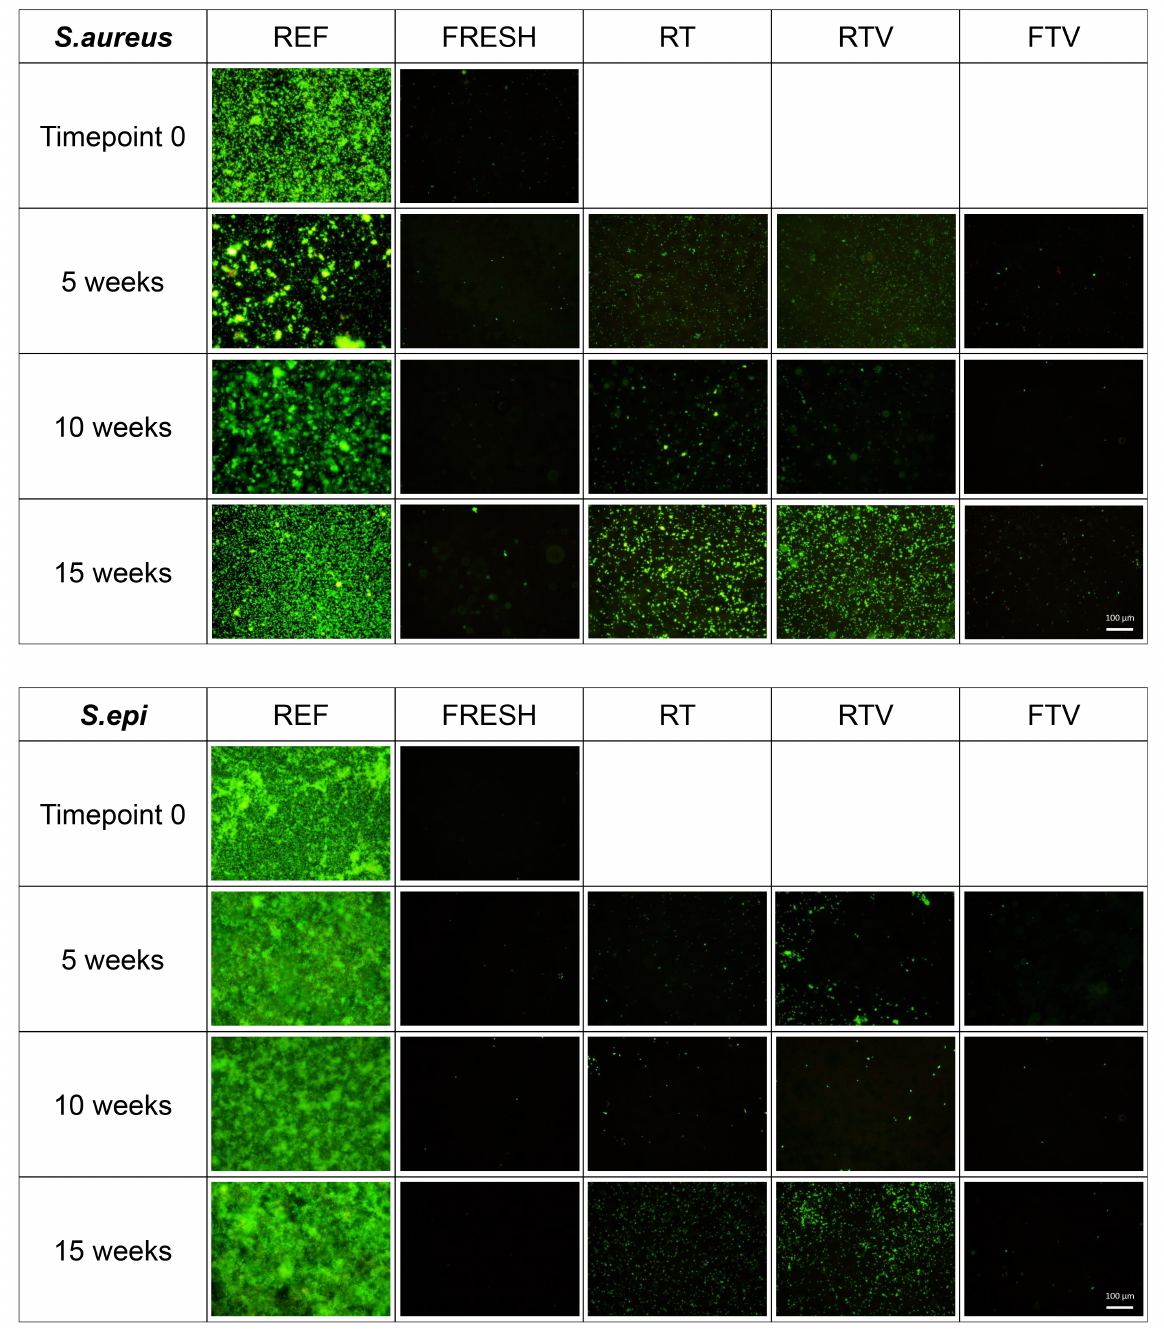
Figure 6. Fluorescence microscopy coatings after incubation with S . aureus ( top ) and S . epidermis ( bottom ) for 24 h, n = 2, qualitative live/dead images (20 ×